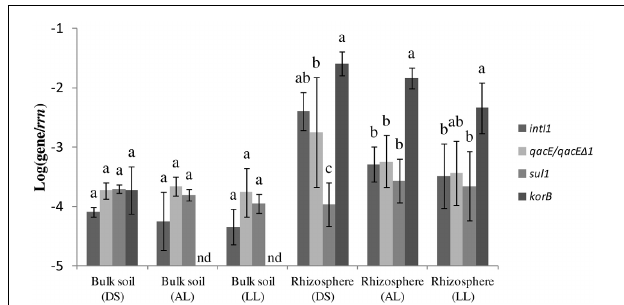
FIGURE 1 | Abundance of class 1 integron integrase gene intI1 , quaternary ammonium compound resistance genes qacE/qacE (cid:2) 1, sulfonamide resistance gene sul1 , and korB genes related to IncP-1 plasmids relative to 16S rRNA gene copies ( rrn ). Results are shown for bulk soil and rhizosphere of lettuce for the three soil types: alluvial loam (AL), diluvial sand (DS), and loess loam (LL). Error bars represent standard deviations of n = 4 replicates or of n = 3 replicates for bulk soil (DS). Values below detection limit ( − 4 . 6) of the qPCR assay for korB are indicated (nd). Pairwise comparisons were made for each soil type of bulk soil and rhizosphere separately. Differing letters indicate significant differences between relative abundances of target genes (Tukey test, p < 0 .